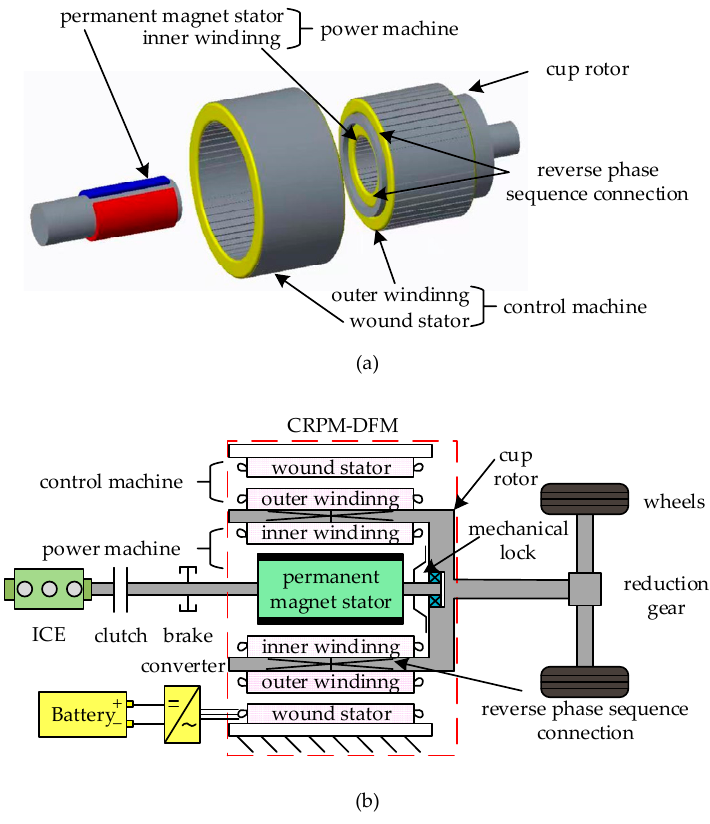
Figure 2. Construction of CRPM-DFM and structure diagram of the powertrain system. ( a ) Construction of CRPM-DFM; ( b ) structure diagram of the powertrain system based on CRPM-DFM. The sum of the torque acting on the cup rotor by the power machine and the control machine is the output torque of the cup rotor, that is: